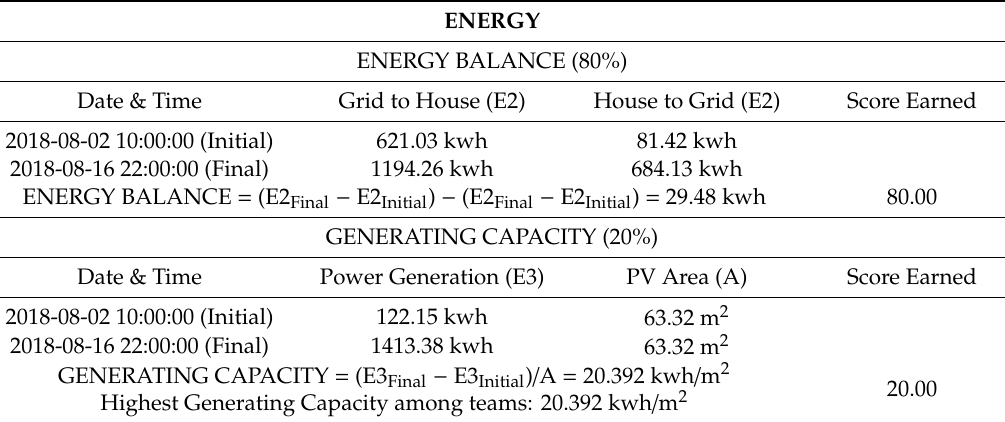
Table 2. Energy Balance